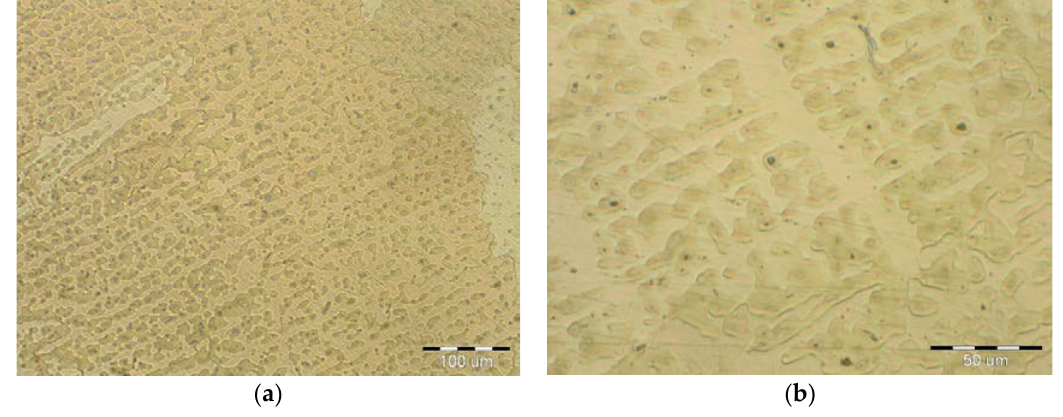
Figure 11. Microstructure of the first-pass layer: ( a ) magnification 200×; ( b ) magnification 500×.